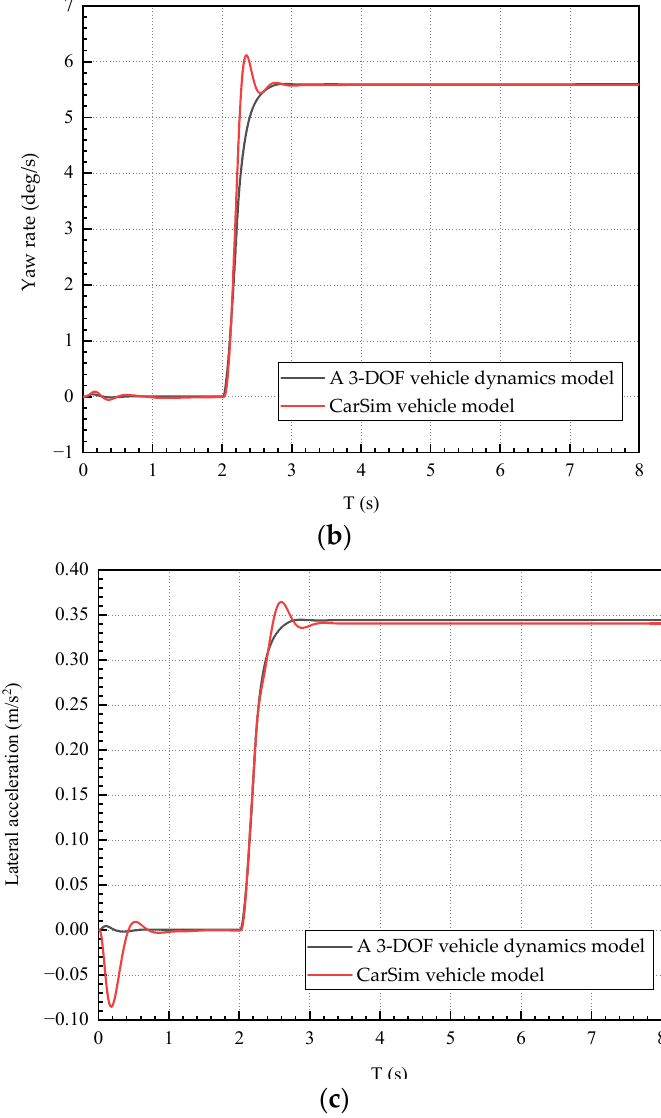
Figure 2. Step-input response curve of steering wheel angle: ( a ) steering angle curve; ( b ) yaw rate; and ( c ) lateral acceleration.